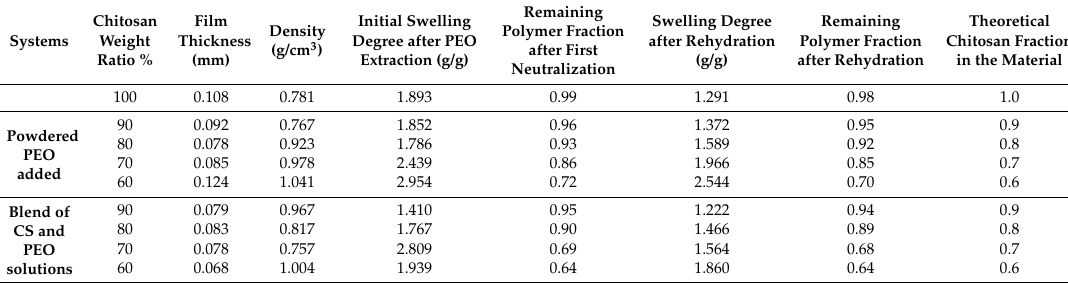
Table 1. Degree of swelling of blended film and composition after chitosan neutralization.